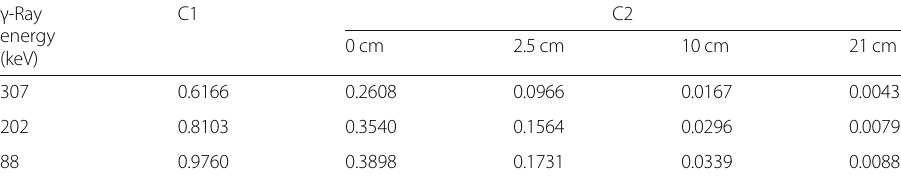
Table 1 Absorption probabilities for monoenergetic photons simulated in GATE, with 88, 202 and 307 keV energy values, absorbed in the source crystal (C1) and the detector crystal (C2). Probabilities for C1 do not depend on the separation distances γ -Ray energy